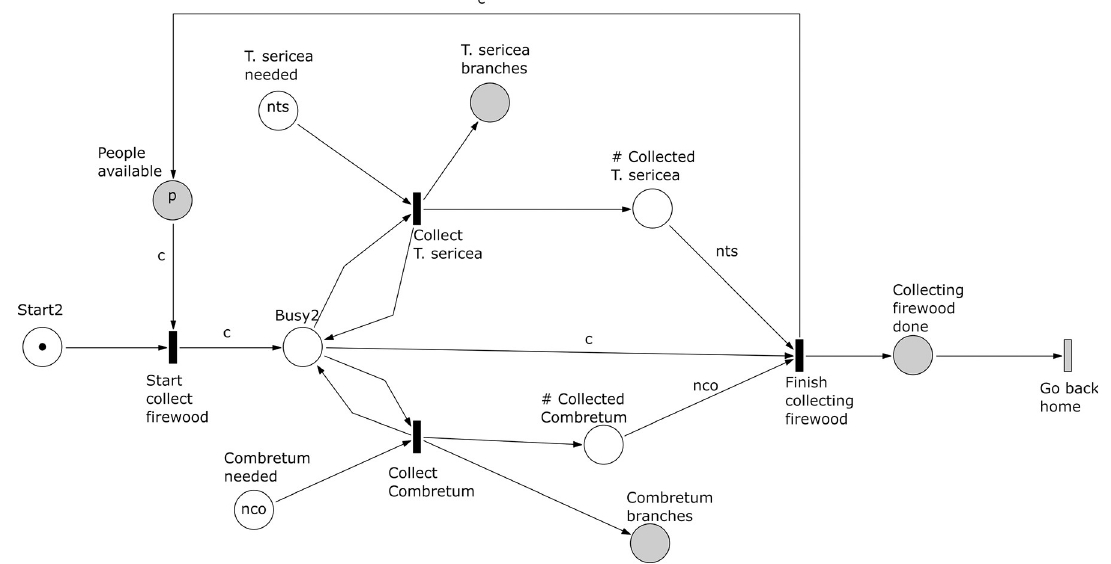
Fig 13. Subprocess 2 Collect Firewood of the O . Schinzii